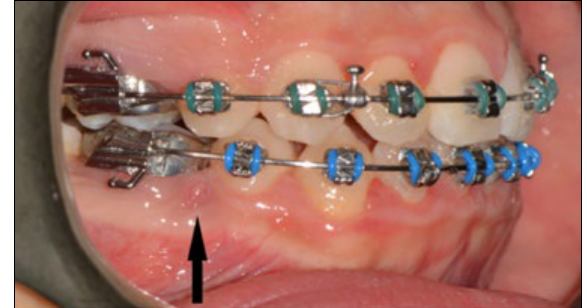
Figure 5. Fifty week progress photo of small fistula between 44 and 46.